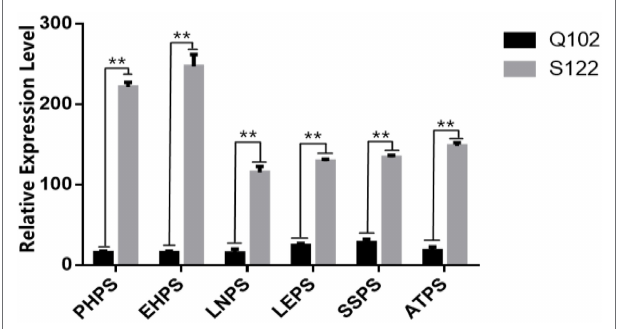
FIGURE 2 | Difference analysis of photoperiod sensitivity between parents. The asterisks (* or **) represent the significant differences at p < 0.05 or p < 0.01,